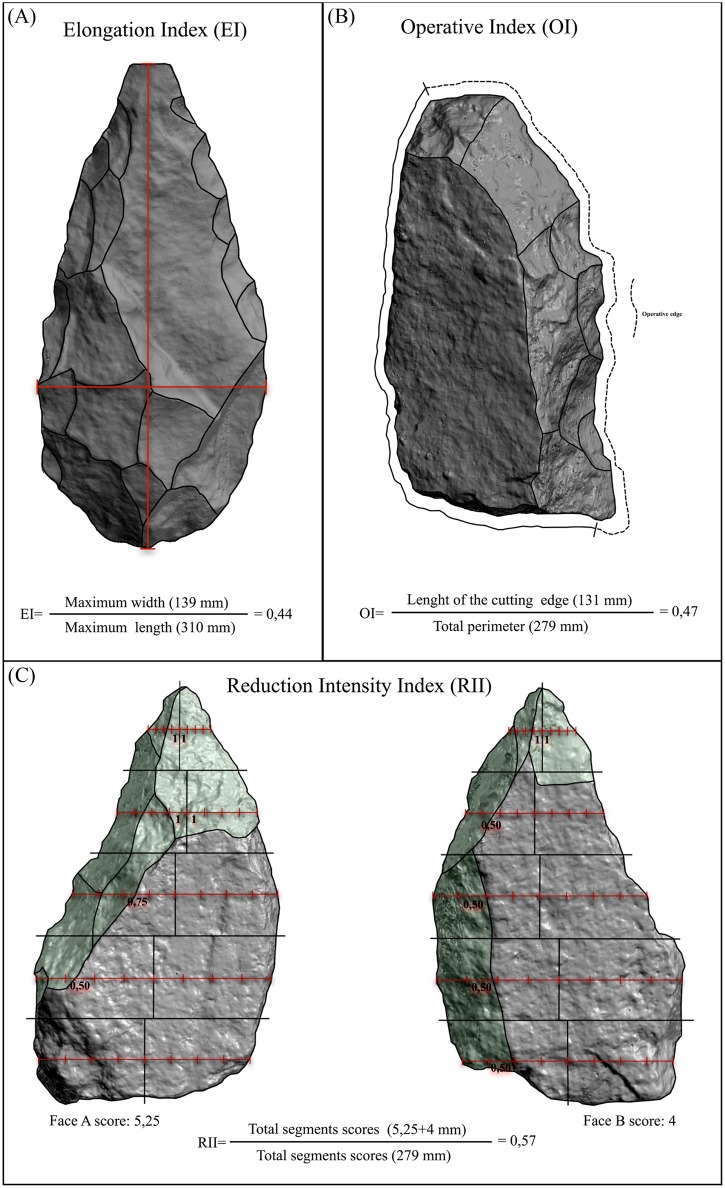
Shape and technological indexes.(A) Elongation Index. (B) Operative Index. (C) Reduction Intensity Index.